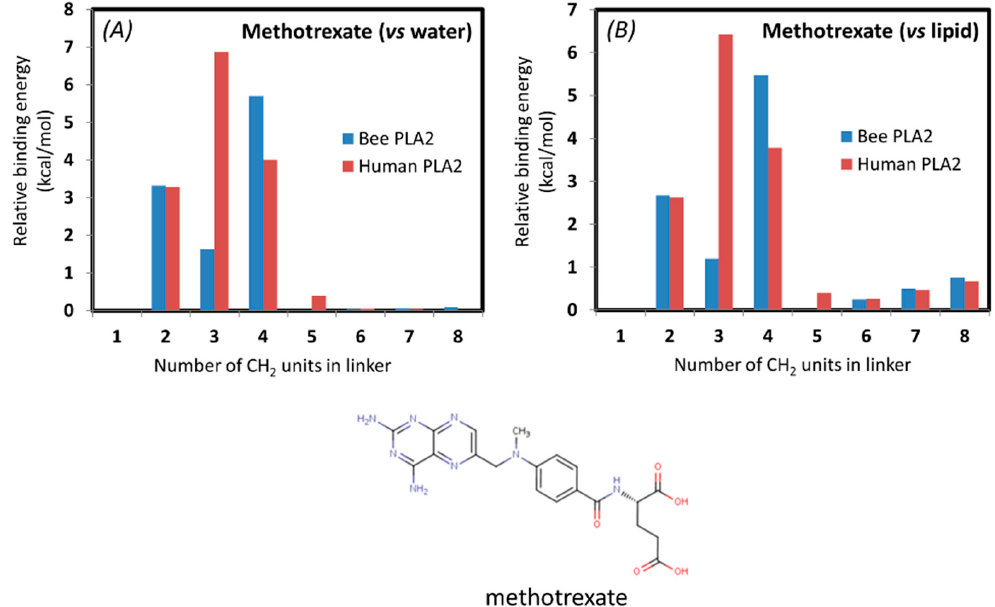
Figure 7. Computed values of binding free energies for the PL-methotrexate prodrugs with different linker lengths in the transition state complex with both human and bee venom PLA 2 in water ( A ) and lipid ( B ) initial state. PLA 2 , phospholipase A 2 ; PL, phospholipid. The standard error for all simulations was 0.5–1.0 kcal/mol.